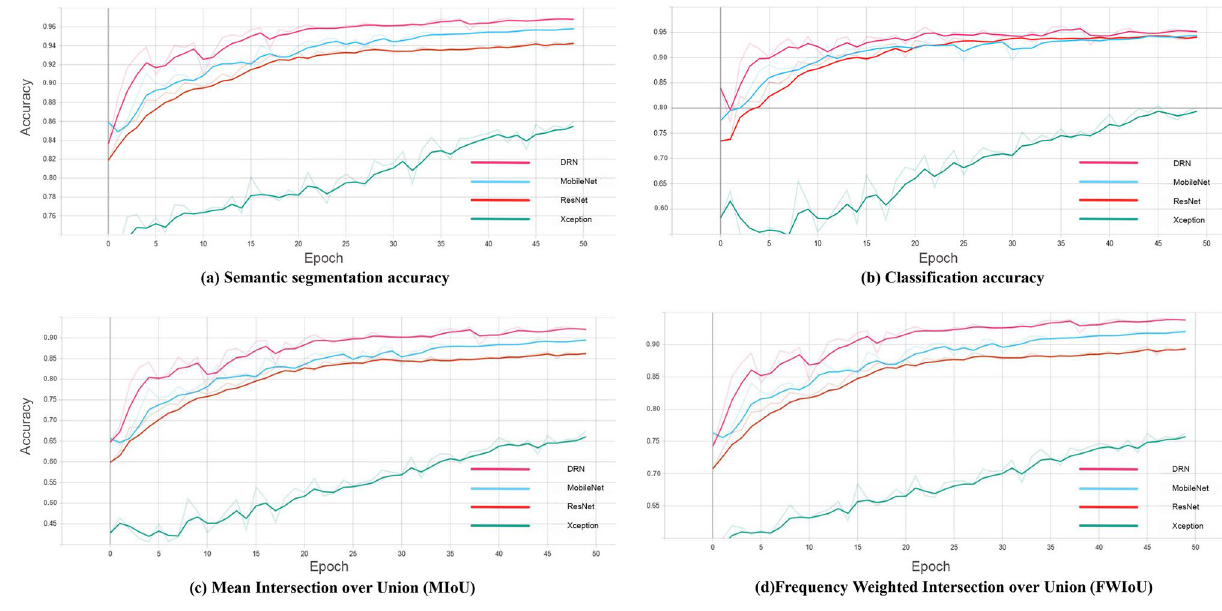
Figure 7. Evaluation index of the second step of joint training: ( a ) Semantic segmentation accuracy, ( b ) Classification accuracy, ( c ) MIoU, ( d )